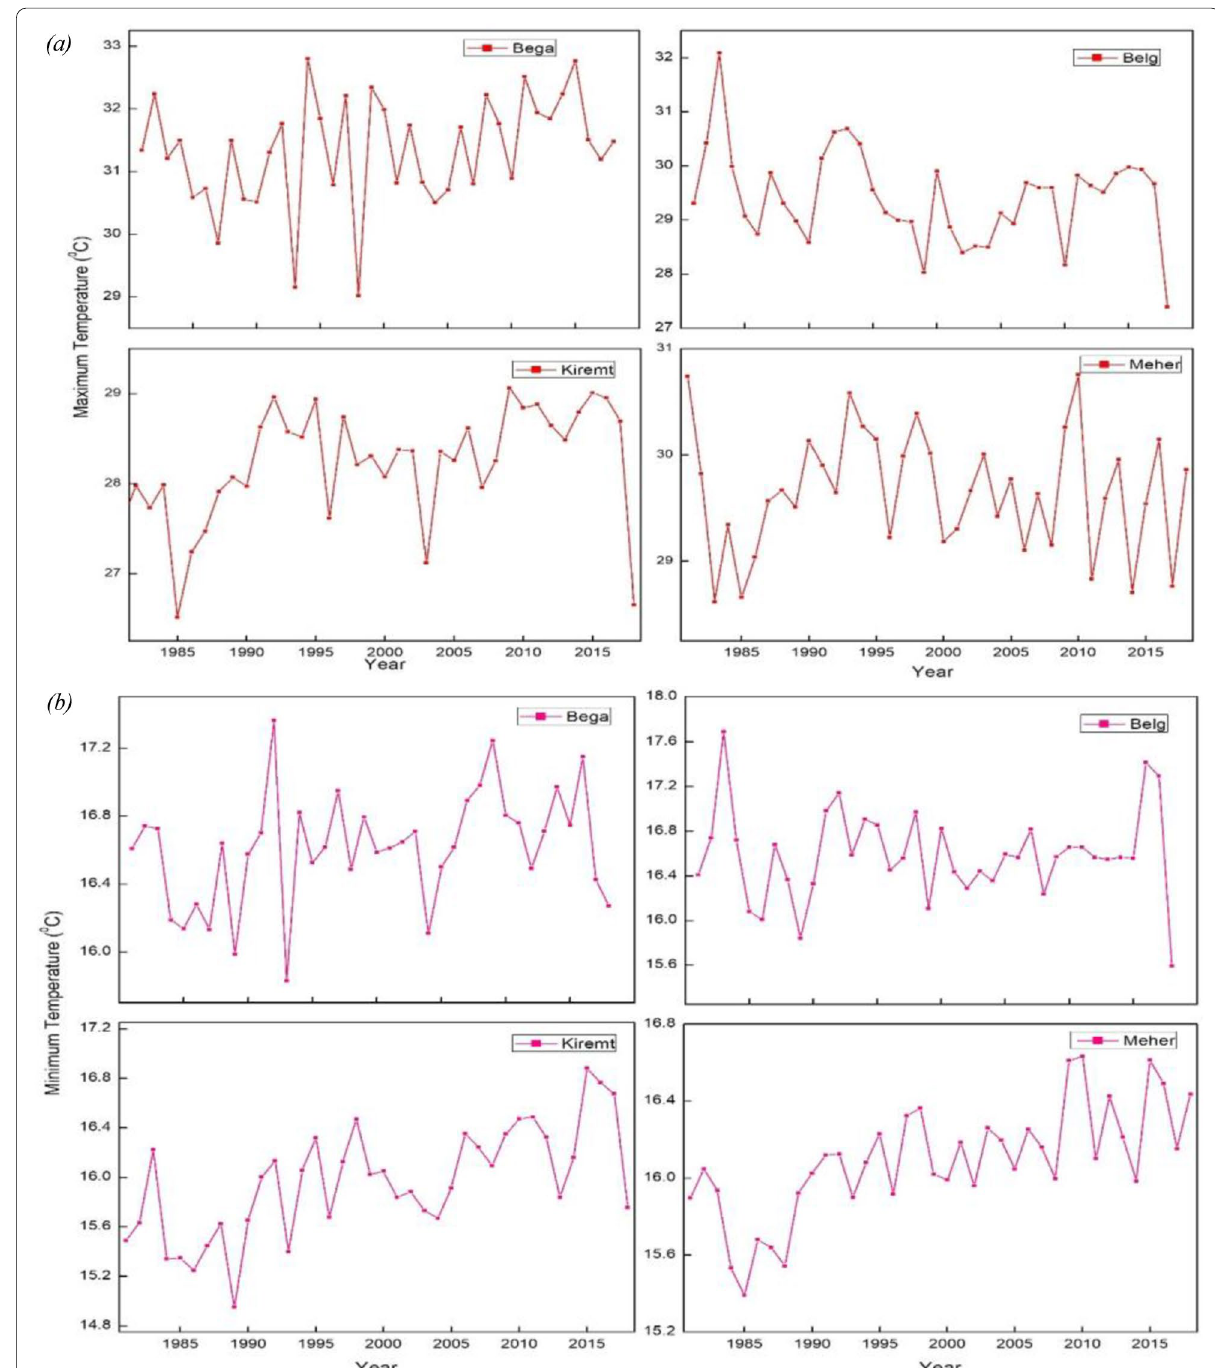
Fig. 7 Seasonal Tmax ( a ) and Tmin ( b ) in semi-arid Borana